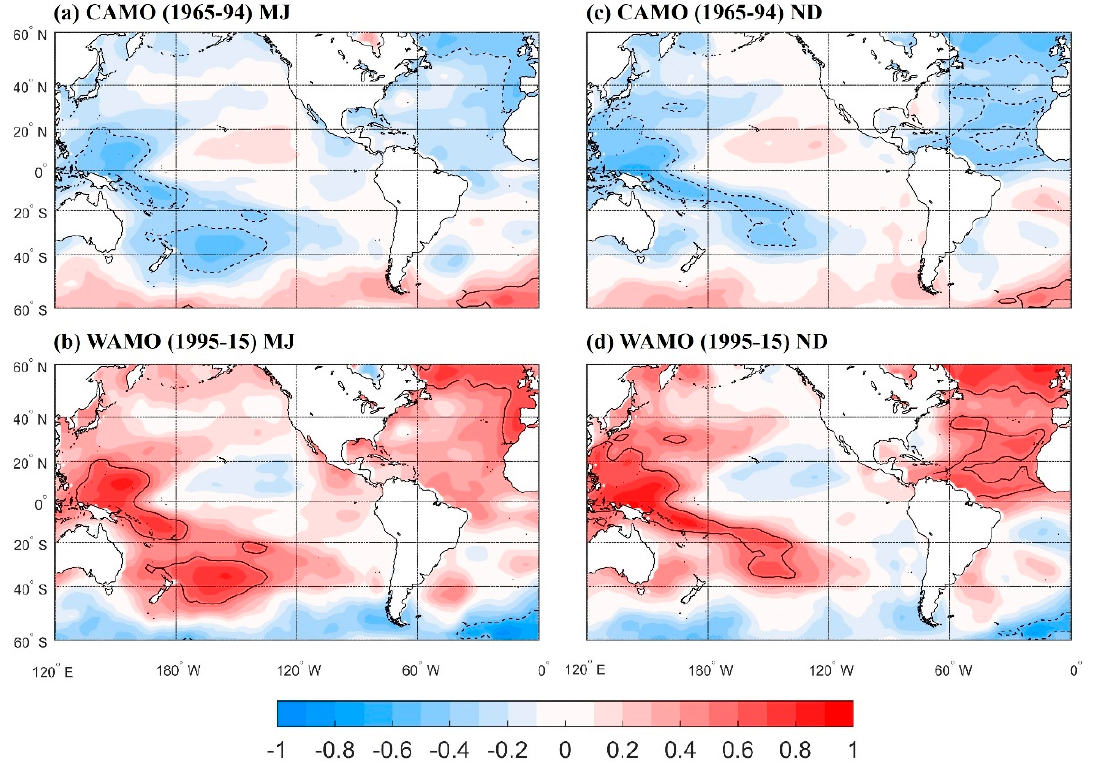
Figure 2. Sea surface temperature (SST) mean standardized anomaly patterns in May–June (MJ) during the ( a ) cold Atlantic Multidecadal Oscillation (CAMO) and ( b ) warm Atlantic Multidecadal Oscillation (WAMO) and in November–December (ND) during the ( c ) CAMO and ( d ) WAMO. The continuous (dashed) line indicates significant positive (negative) values at the 95% confidence level using the Student’s t-test. The contour range is 0.1 standard deviations with red (blue) shades for positive (negative) values. The continuous (dashed) line encompasses significant positive (negative) values at the confidence level of 95%.